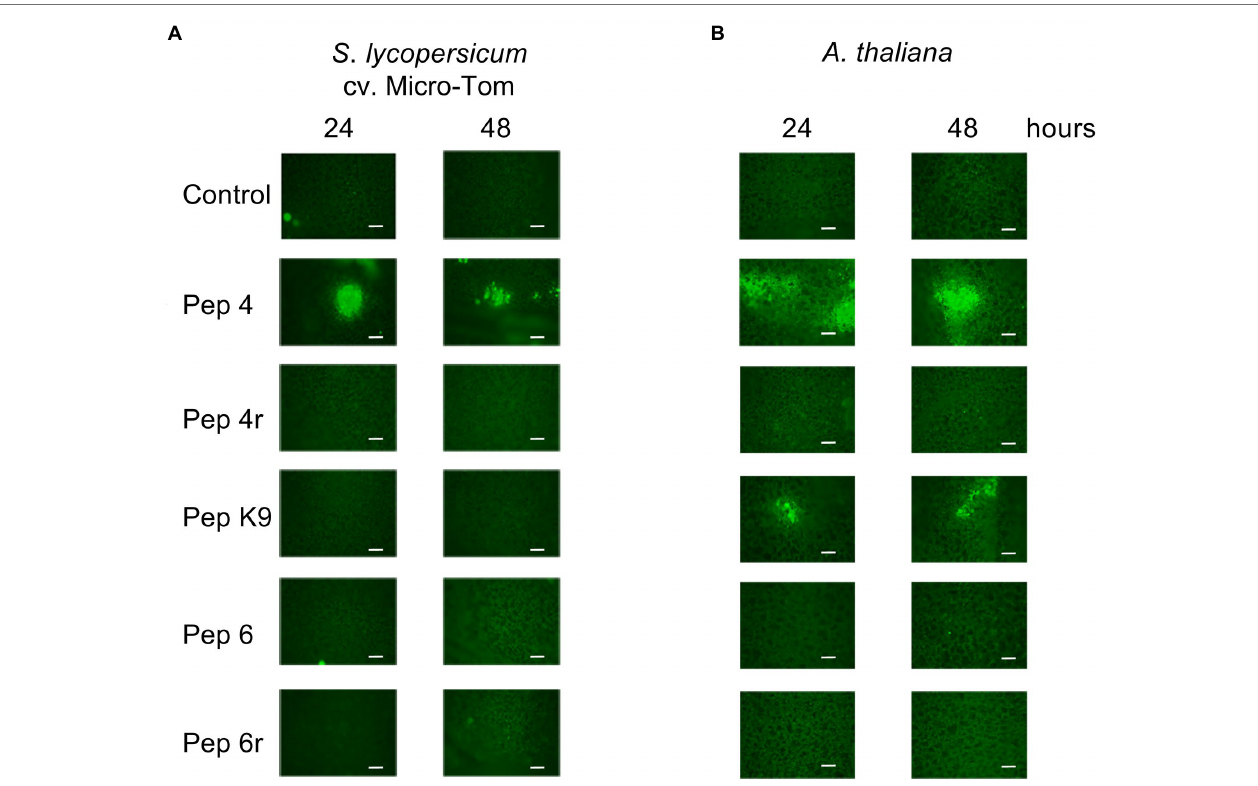
FIGURE 6 | Reactive oxygen species (ROS) detection on Solanum lycopersicum cv. Micro-Tom (A) or Arabidopsis thaliana Col-0 (B) leaves. Leaves were treated with droplets containing 50 μ M Trichogin GA IV-derived peptides for 24 and 48 h, and subsequently stained with the fluorescent probe 2 ′ ,7 ′ -dichlorodihydrofluorescein diacetate (H 2 DCFDA) to visualize ROS production in situ . A representative picture per treatment is shown. Scale bars: 200 μ